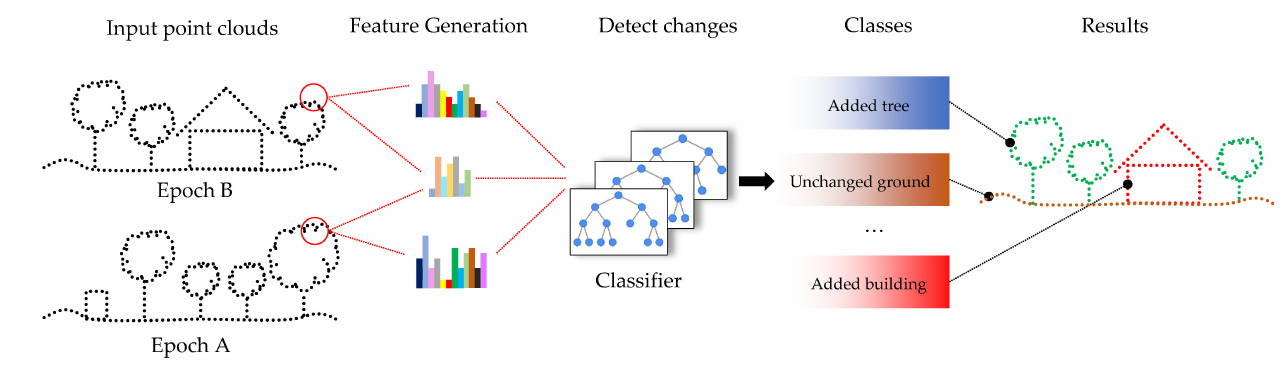
Figure 7. General 3D CD framework using handcrafted features.